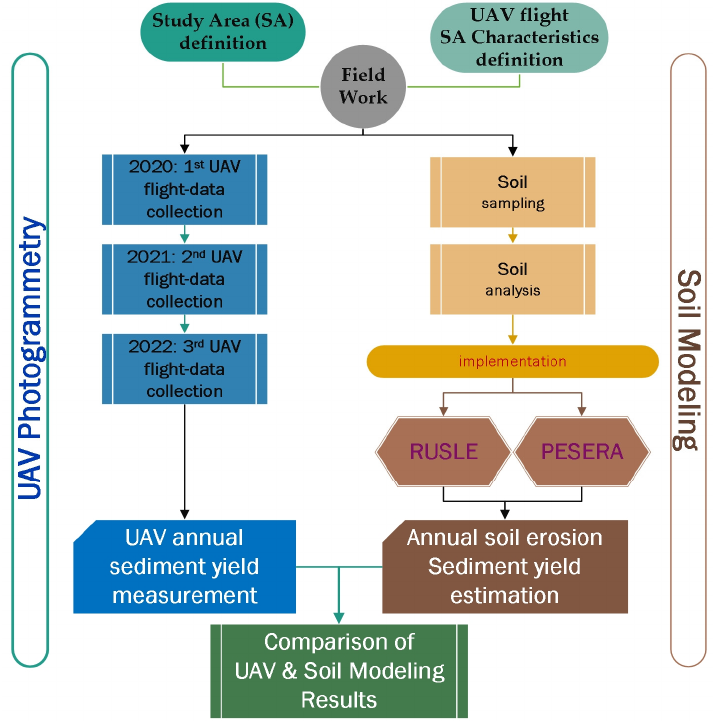
Figure 7. Complete survey